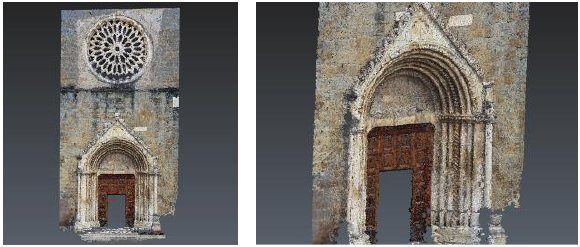
Figure 17. First test of point cloud generation of the portal before the